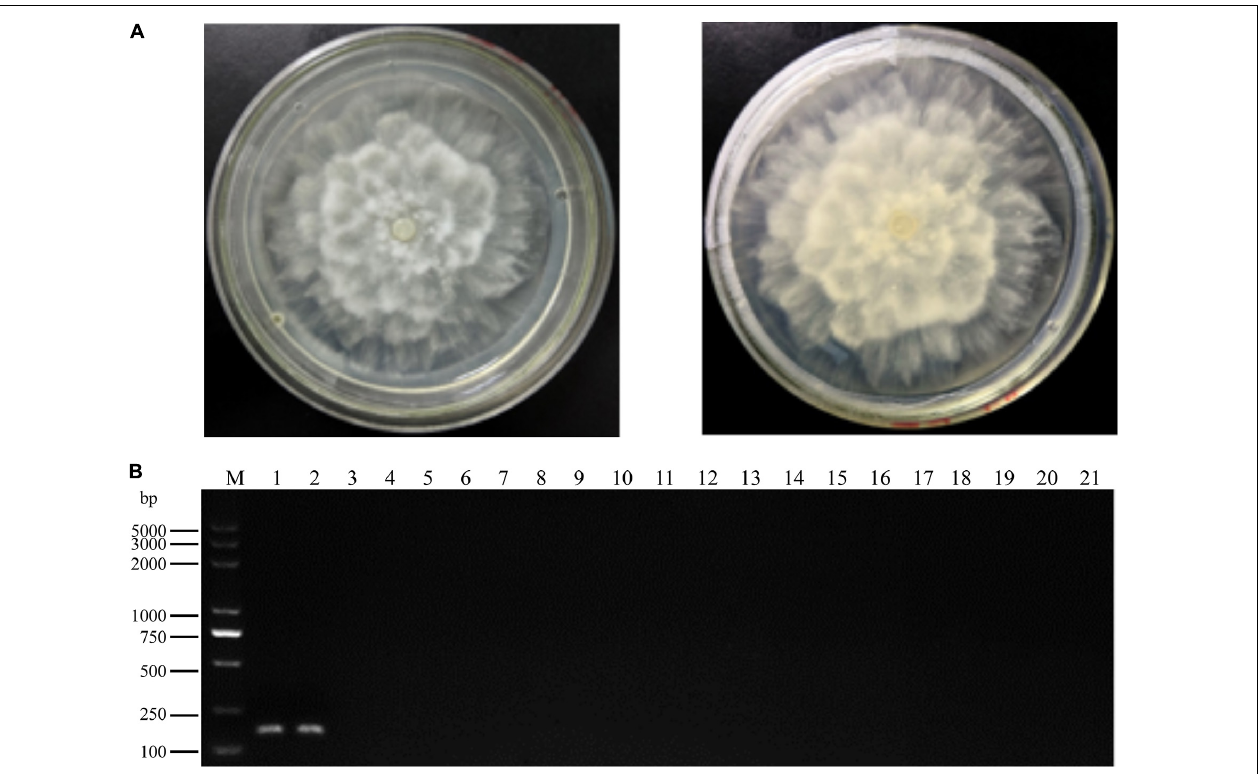
FIGURE 1 | Colony morphology and specific polymerase chain reaction (PCR) primer detection of Phytopythium vexans. (A) Colony morphology of P. vexans. (B) Confirmation of primer specificity for P. vexans, lanes 1 and 2 are strains of P. vexans; lanes 3–20 correspond to the following species Pythium spinosum, Pythium irregulare, Pythium sylvaticum, Phytopythium helicoides, Pythium ultimum, Pythium myriotylum, Phytopythium litorale, Pythium oligandrum, Pythium heterothallicum, Pythium carolinianum, Pythium guiyangense, Pythium aphanidermatum, Pythium recalcitrans, Fusarium oxysporum, Fusarium graminearum, Fusarium solani, Fusarium verticillioides, and Phytophthora capsici , respectively; lane 21 is a negative